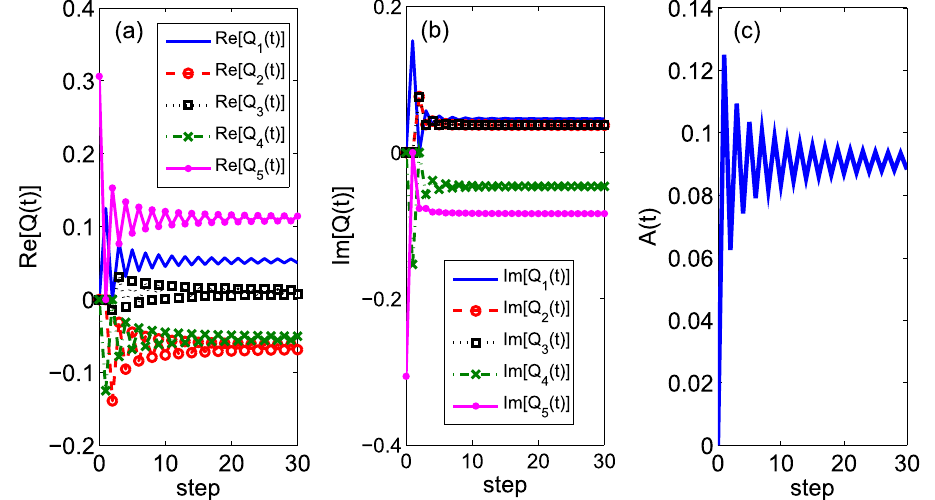
Figure 1. The step evolution of = … Q t i ( ) ( 1 5) and A ( t ) in Eq. 7. The initial total state for this two i dimensional QW is taken as   + . ( a ) The step evolution of the real part of Q i ( t ); ( b ) The step evolution of the imaginary part of Q i ( t ); ( c ) The step evolution of A ( t